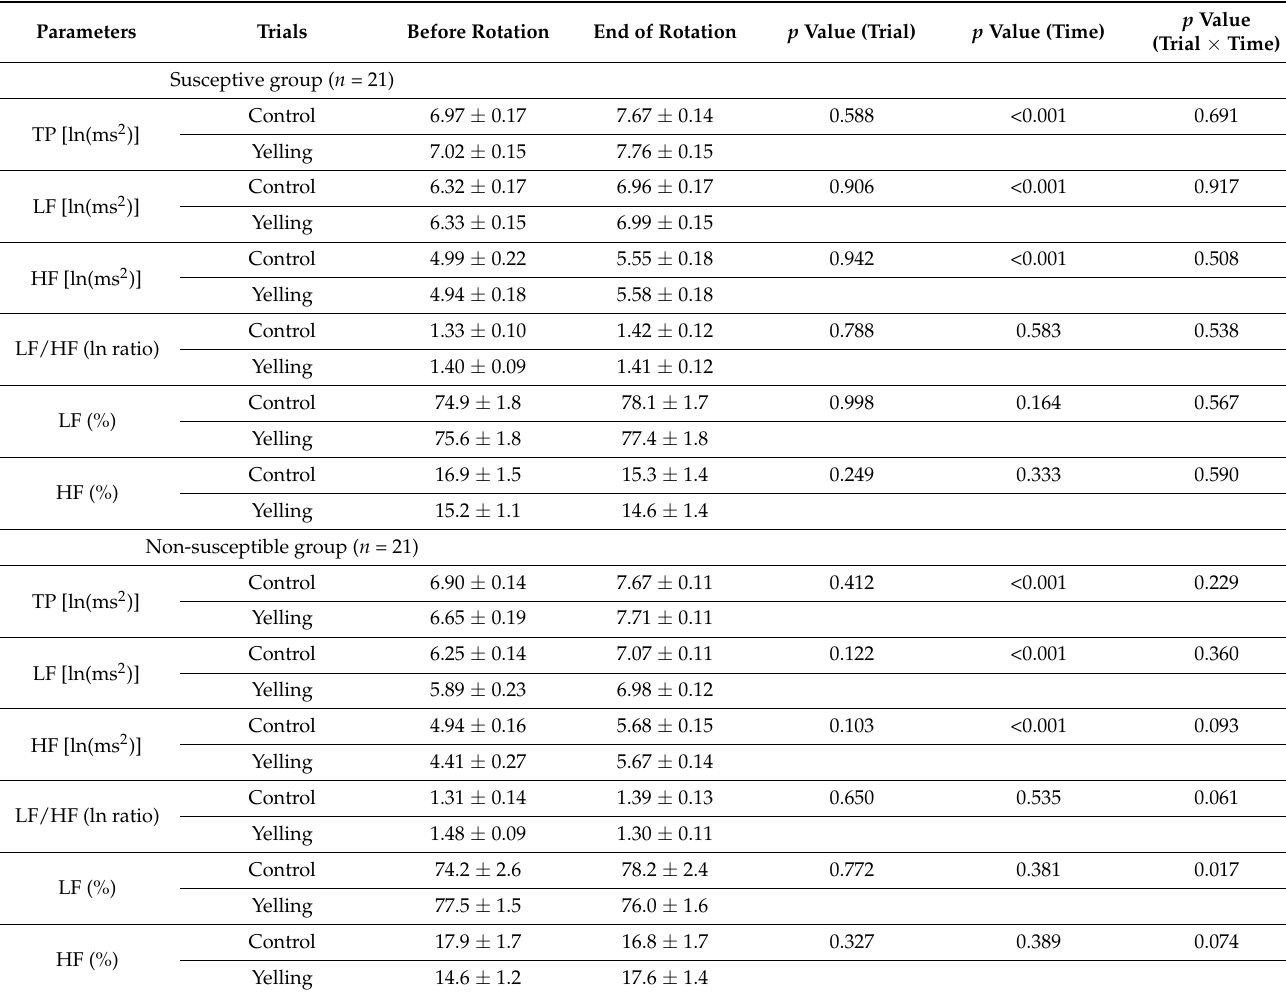
Table 4. Effects of the yelling intervention on HRV activity in rotation stimulation between the susceptible and non- susceptible